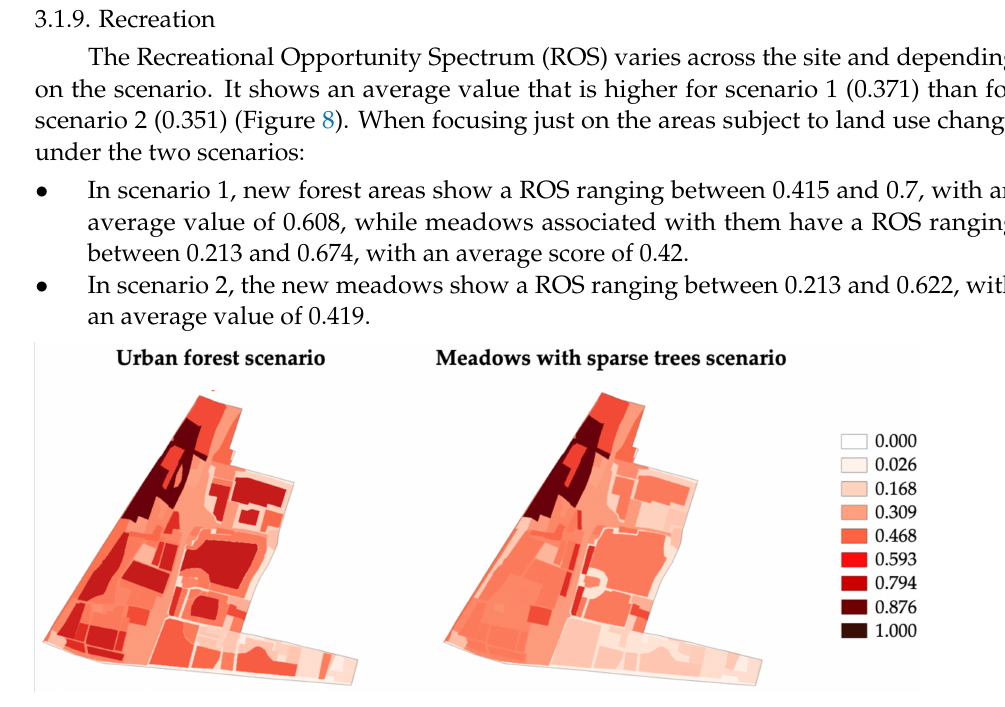
Figure 8. Recreation Opportunities Spectrum for the two intervention